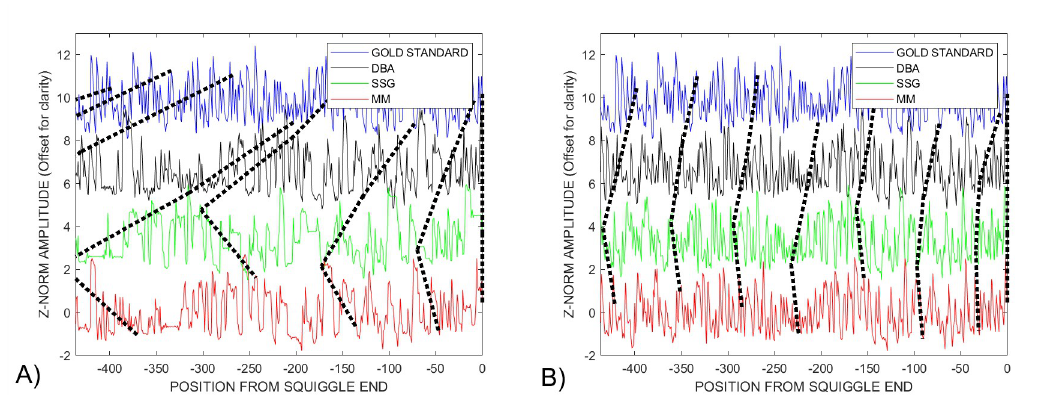
Fig 10. The dashed and solid lines join points in these un-warped signals with points identified as having equivalent warped path positions by the DTW algorithm. A) There is much less similarity amongst the Enolase DTWA consensus signals and to the gold standard before voting than B) after voting. Note that both pictures show the presence of common signals in the last part of all consensus signals that are absent in the gold standard. This difference is responsible for the strong distortions near the end of the Difference-from-Identity warped path plot, Fig